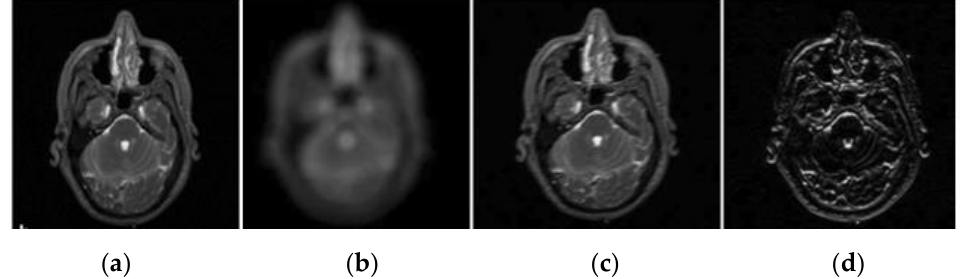
Figure 3. ( a ) Wavelet decomposition of MRI image, ( b ) input image, ( c ) lower frequency component, and ( d ) higher frequency component.